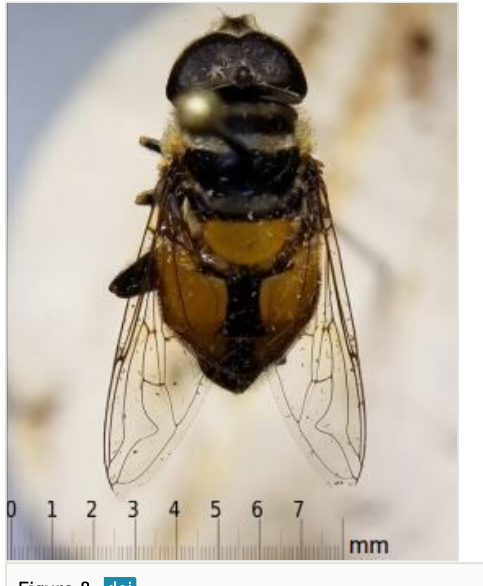
Figure 8. Collected specimen of Palpada agrorum , with scale.